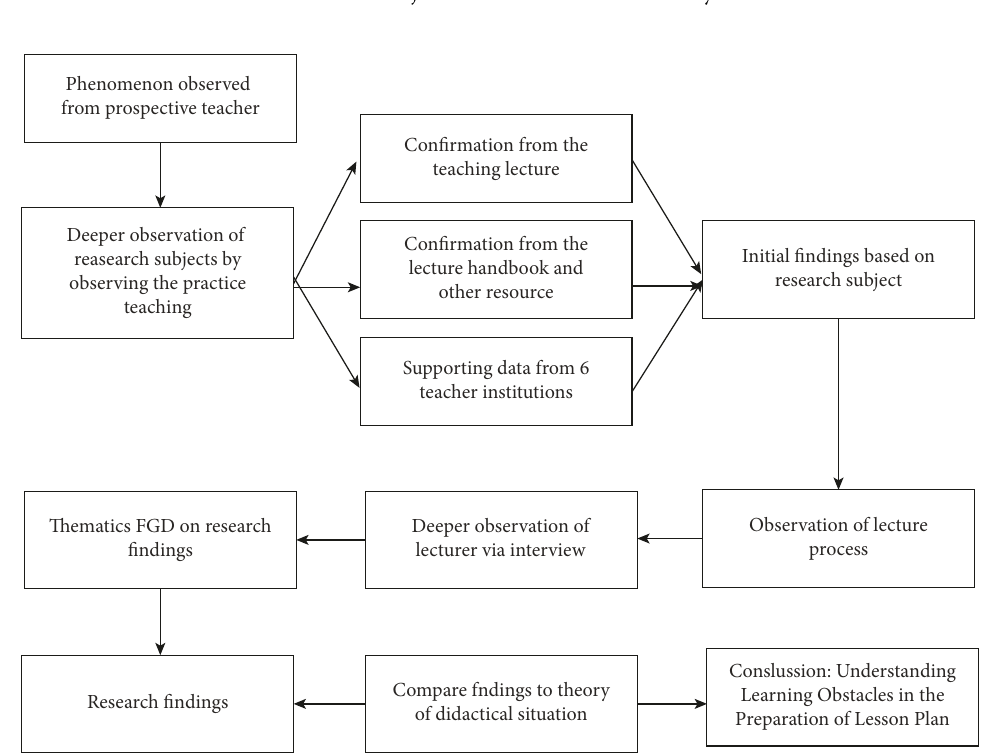
Figure 3: The research